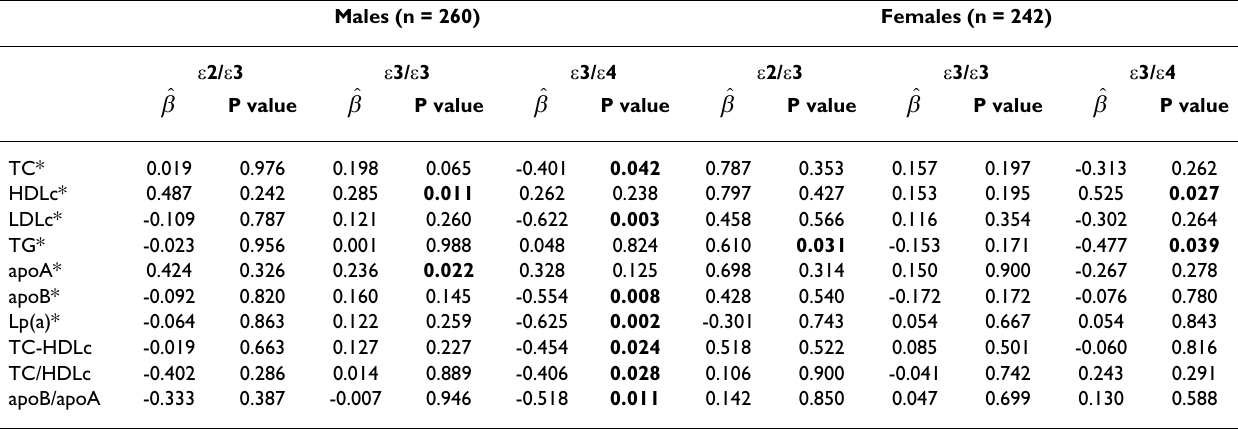
Table 5: Regression coefficients ( ) showing the association between birth weight score and lipid and lipoprotein levels by APOE genotypes and sex after controlling for age, pubertal stage, socioeconomic status, gestational age, body mass index and cardiorespiratory fitness